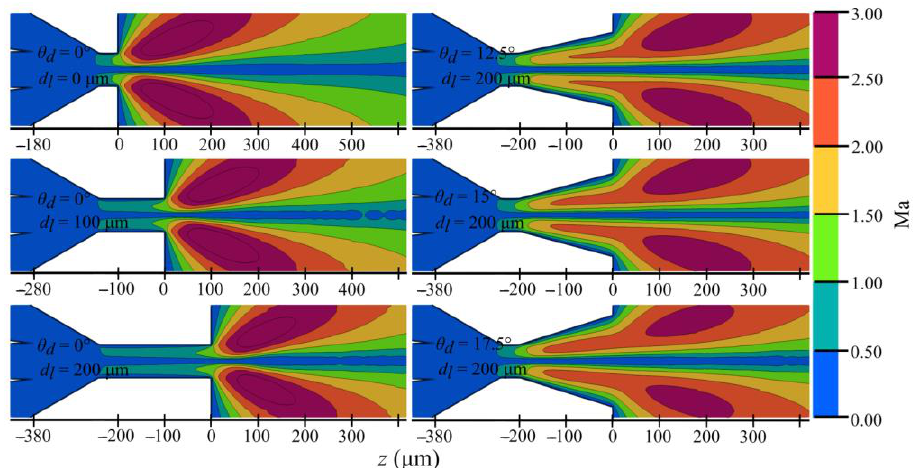
Figure 10. Mach number maps for selected 6 nozzle outlet orifices from Table 3.